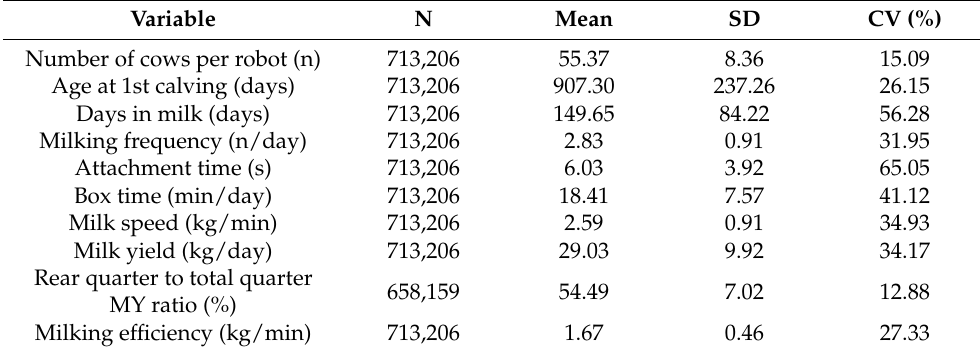
Table 2. Descriptive statistics of tested traits.